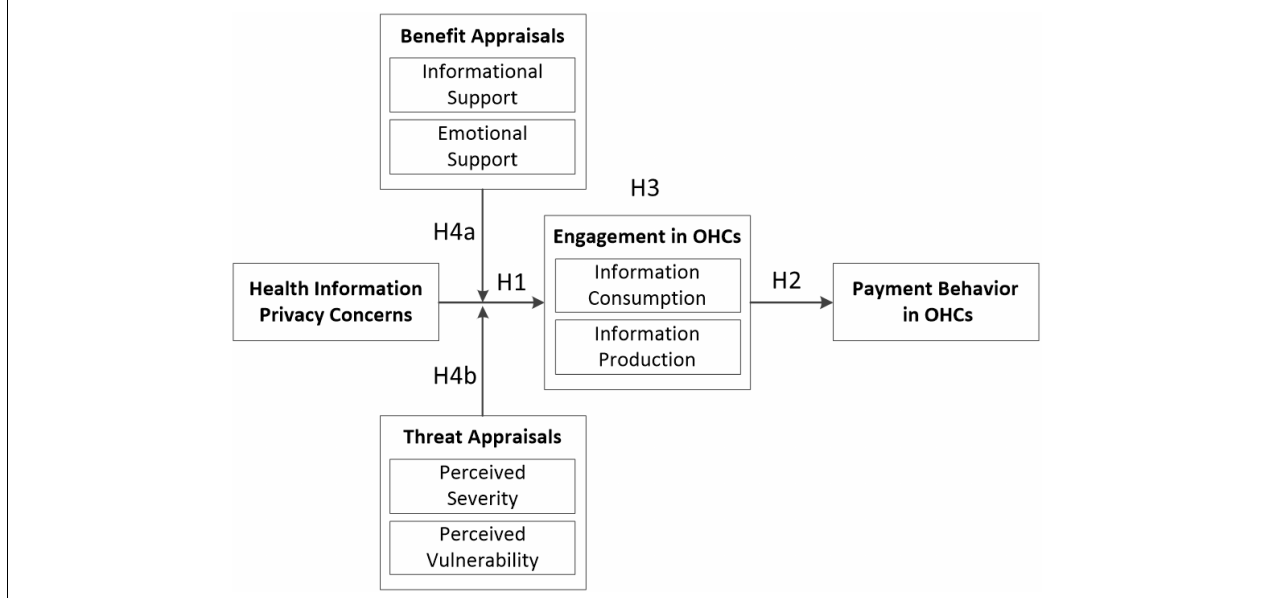
FIGURE 1 | Theoretical